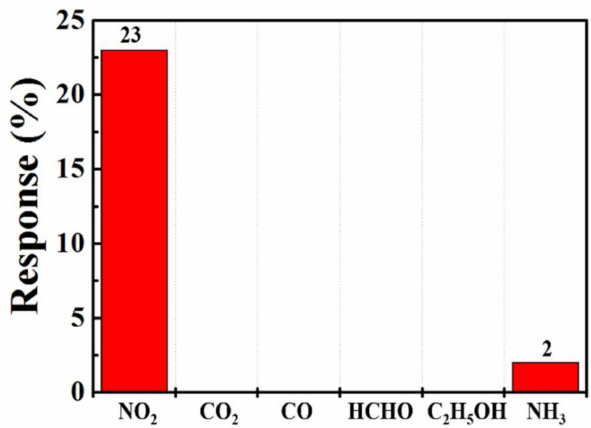
Figure 12. Responses of the sensor toward various target gases at 150 ◦ C.